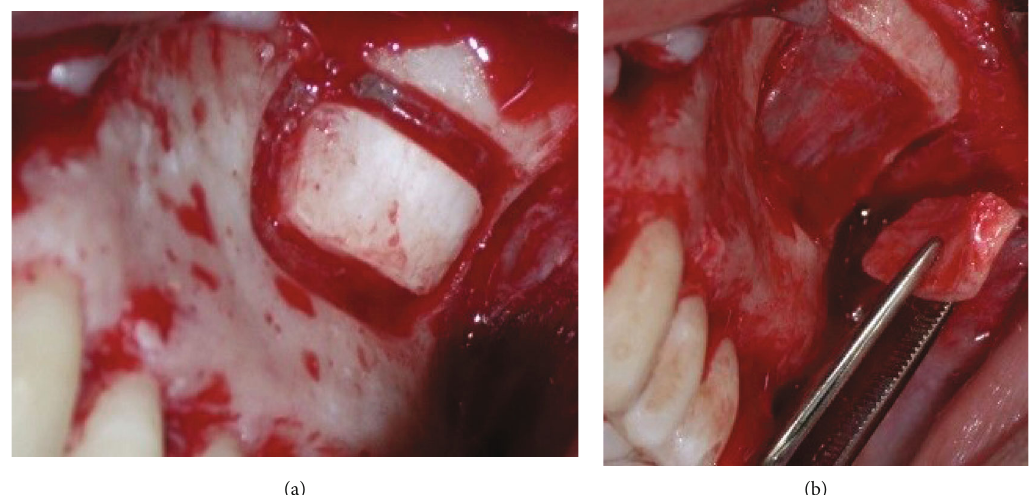
Figure 2: View of the donor site — lower tail of the ZB — in case no. 1: (a) bone cut with the piezoelectric surgical device; (b) ZB bone block